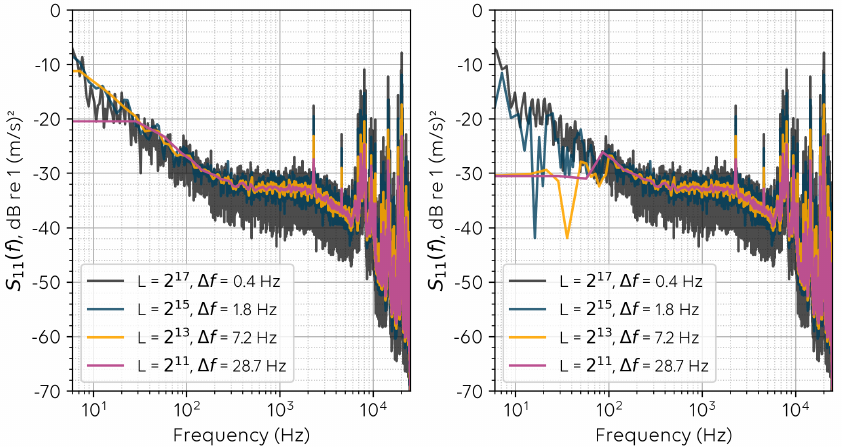
Figure 8. PSD of the longitudinal velocity component from measured hot-wire data and estimated with four different window sizes. The window sizes and frequency resolutions are marked in the label. ( Left ): Raw data. ( Right ): After the low frequency distortion removal technique as introduced in Section 3.2.